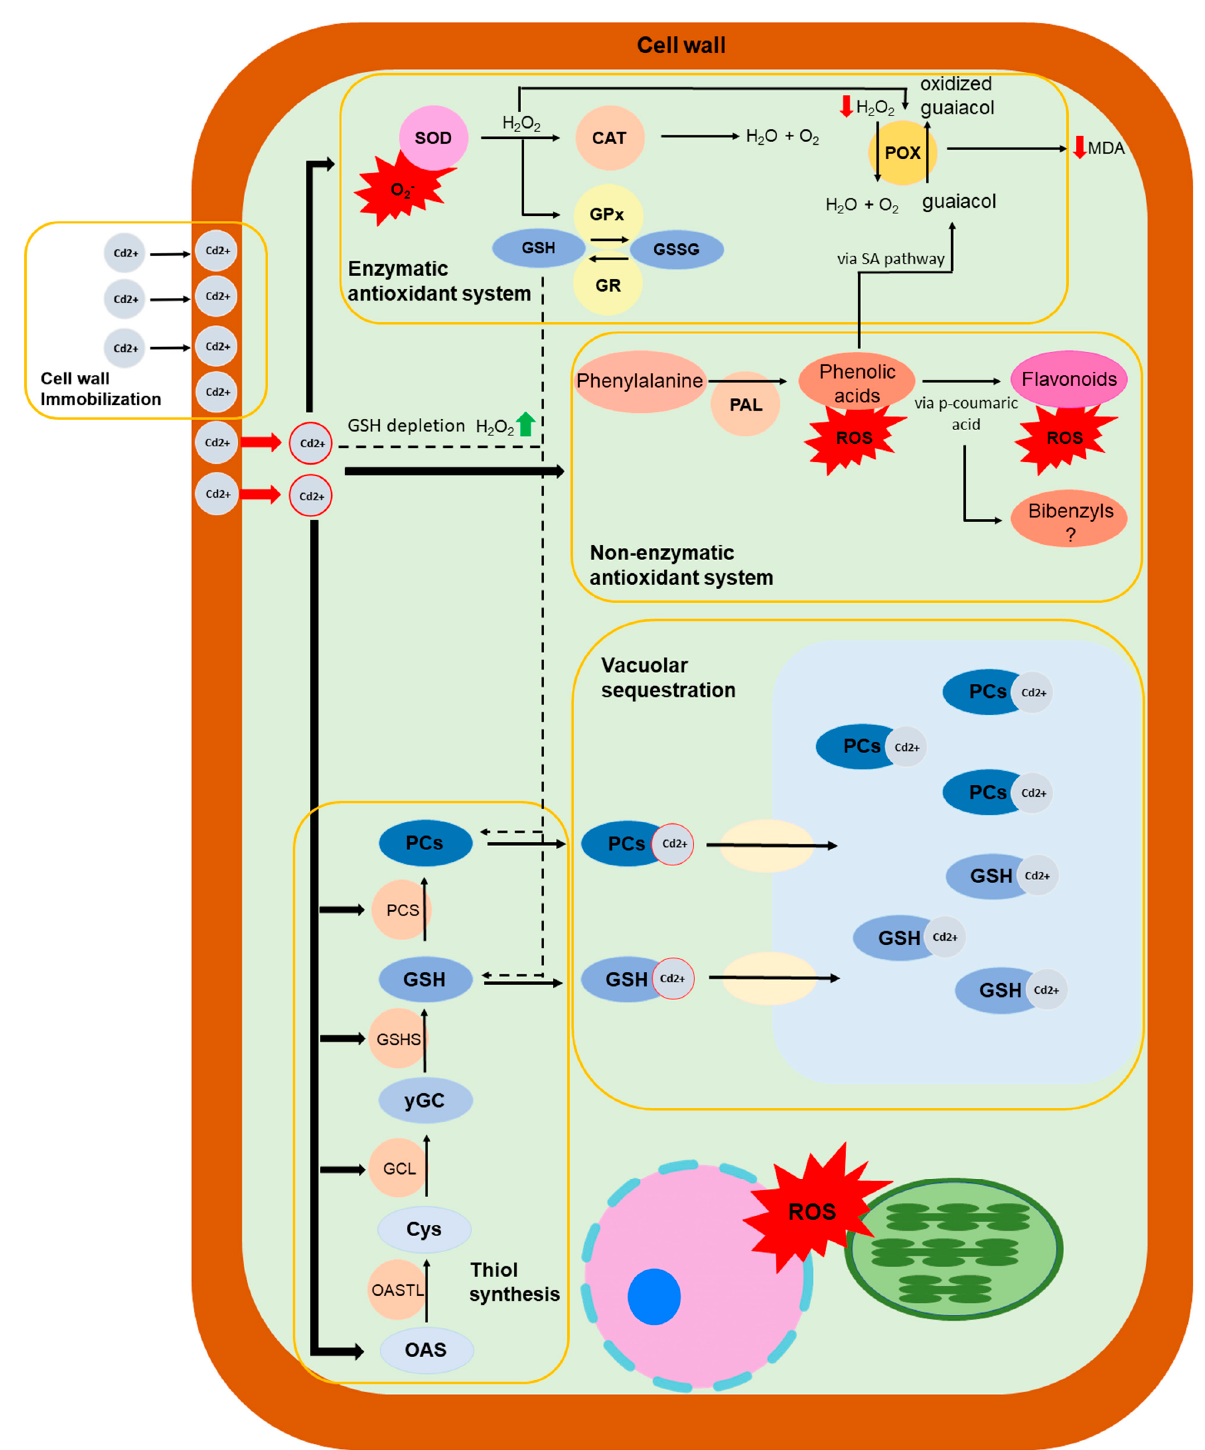
Figure 2. Schematic diagram of the mechanisms involved in metal tolerance in bryophytes. Cadmium is selected as an example specimen. List of abbreviations: SOD (superoxide dismutase), CAT (catalase), GPx (glutathione peroxidase), GR (glutathione reductase), POX (guaiacol peroxidase), PAL (phenylalanine ammonia lyase), OASTL (O-acetylserine (thiol) lyase), GCL (glutamate-cysteine ligase), GSHS (glutathione synthetase), PCS (phytochelatin synthetase), Cys (cysteine), OAS (O-acetylserine), yGC (y-glutamylcysteine), GSH, (reduced glutathione), GSSG (oxidized glutathione), PCs (phytochelatins), MDA (malondialdehyde), ROS (Reactive Oxygen Species).